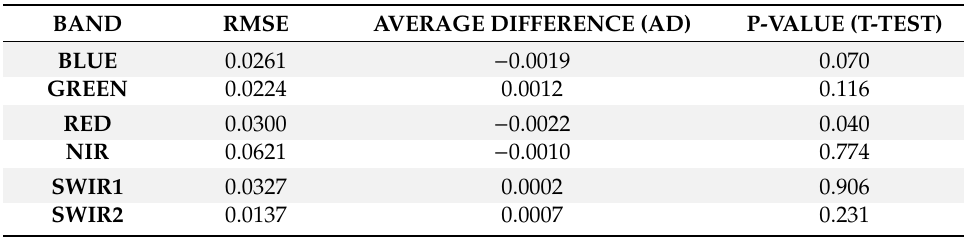
Table 2. RMSE and average di ff erence (real reflectance minus predicted reflectance) of the blue, green, red, and near-infrared (NIR), shortwave infrared 1 (SWIR1), and shortwave infrared 2 (SWIR2) bands for Fairbanks,